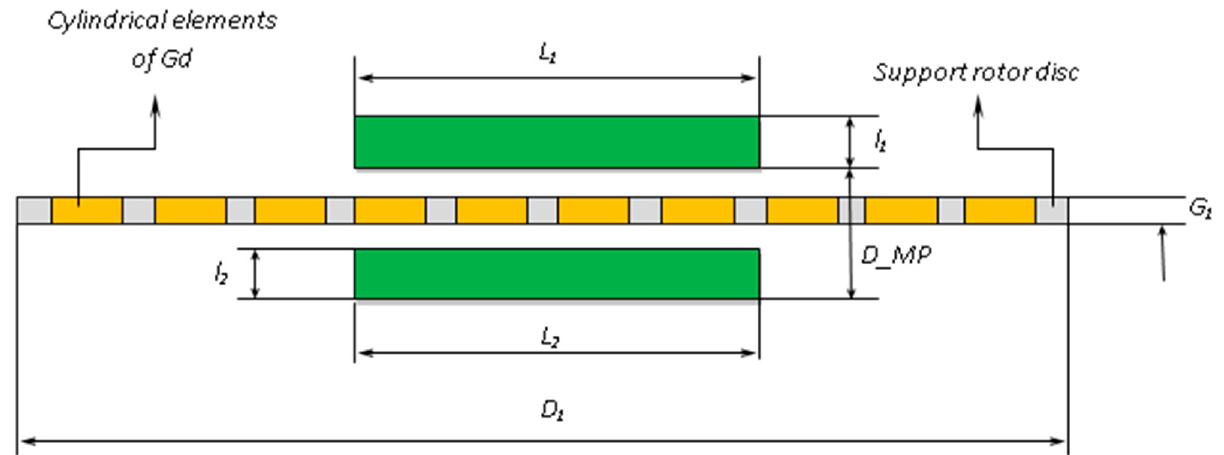
Figure 12. Geometric parameters of the physical model considered in the simulation.